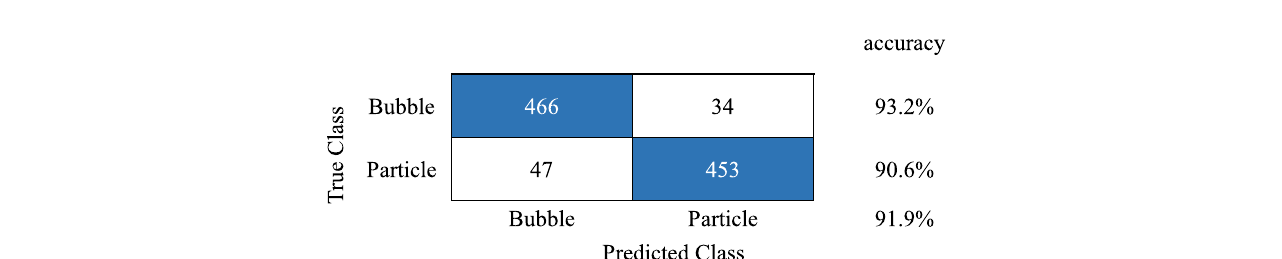
Table 3. Confusion matrix for test data.